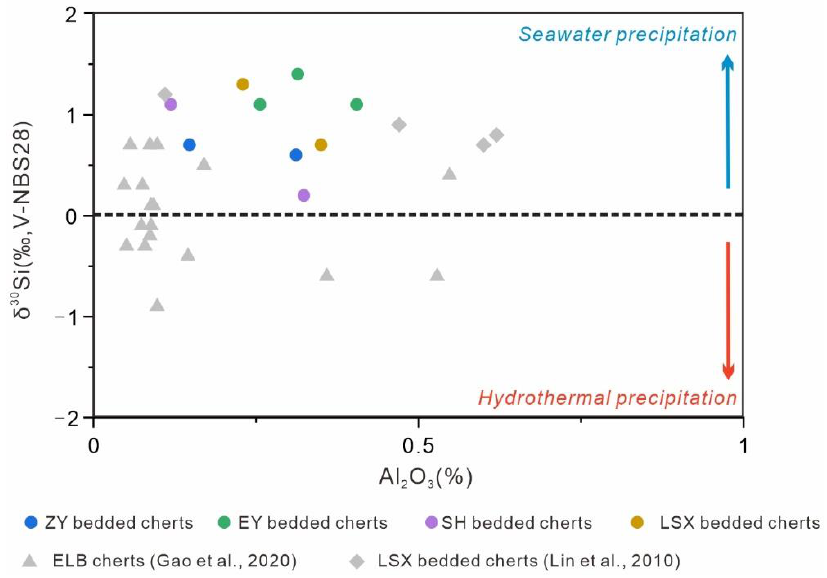
Figure 9. Correlation of δ 30 Si and Al 2 O 3 concentrations of the Maokou cherts (data of ELB cherts from [22] ; data of LSX cherts from [43] ).